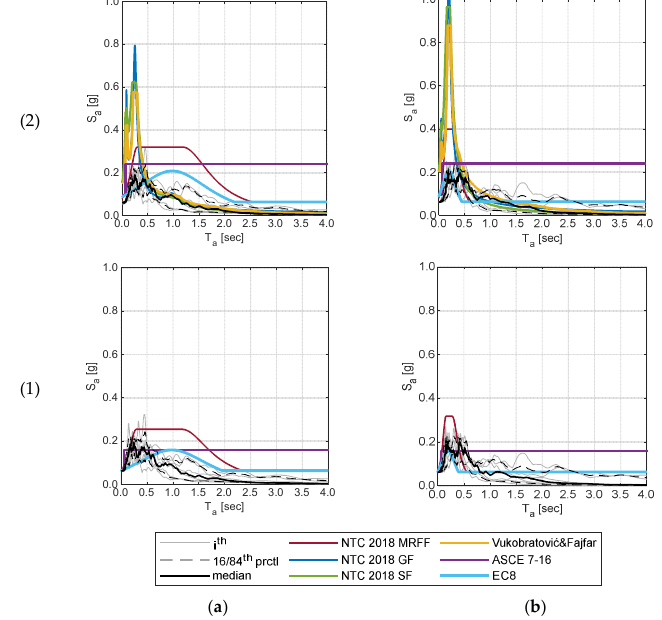
Figure 7. Comparison of floor spectra obtained for a seismic action with a return period of 475 years for unit A, for the different accelerograms at the different building levels (one level in each row, indicated by numbers), their median (black thick line) and 16/84th percentile (black dashed lines) spectra, and the code floor spectra: ( a ) direction X; ( b ) direction Y.